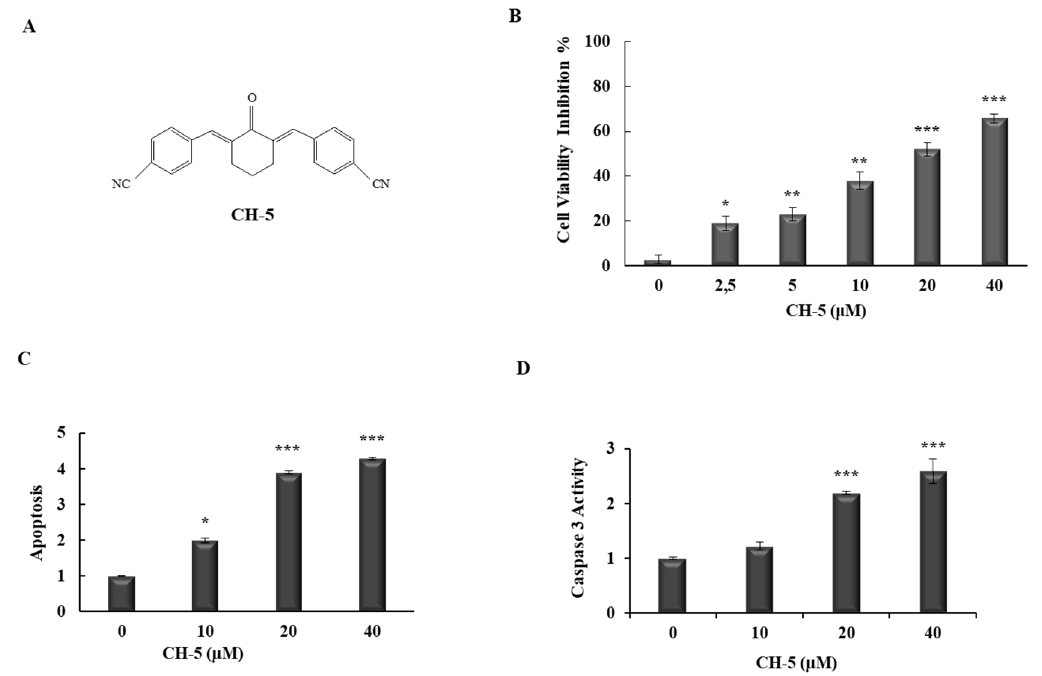
Figure 1. Cellular viability of HGC-27 cells treated with CH-5. ( A ) Chemical structure of CH-5; ( B ) HGC-27 cells were treated with DMSO (0.1%) or with 0, 2.5, 5, 10, 20, 40 µM of CH-5, and after 24 h their viability was measured by an MTT assay. Each experiment was performed in quadruplicate; ( C ) Apoptosis induction by CH-5. HGC-27 cells were treated with DMSO (0.1%), or 10, 20, and 50 µM of CH-5, and after 24 h the rate of apoptotic cells was assessed by double staining (Annexin V-FITC/PI) flow cytometry assay. Y-axis represents fold induction compared to DMSO-treated cells; ( D ) Apoptosis was further confirmed by measuring caspase 3 activity in HGC-27 cells treated with CH-5. After treatment with CH-5 at the indicated concentrations, protein lysates were mixed with caspase-3 substrate, and then caspase-3 activity was determined by measuring absorbance, according to the manufacturer’s instructions described in the materials and methods section. Y-axis represents relative caspase activity compared to DMSO-treated cells. In all experiments, the data represent the mean ± SD of three experiments. * p ≤ 0.05, ** p ≤ 0.01, and *** p ≤ 0.001 compared with DMSO